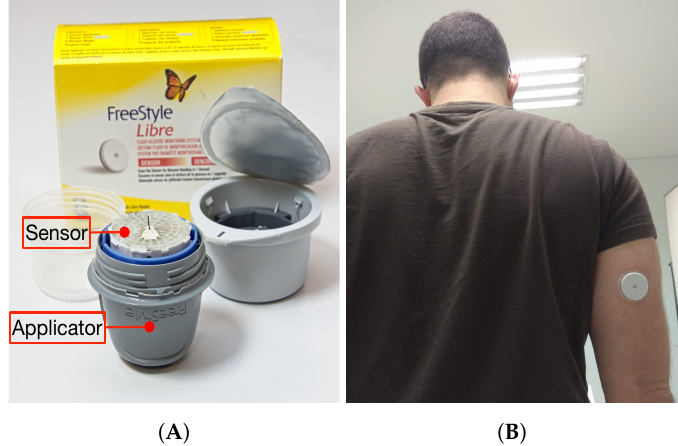
Figure 2. Abbott’s Freestyle Libre sensor and applicator ( A ), and adhered sensor ( B